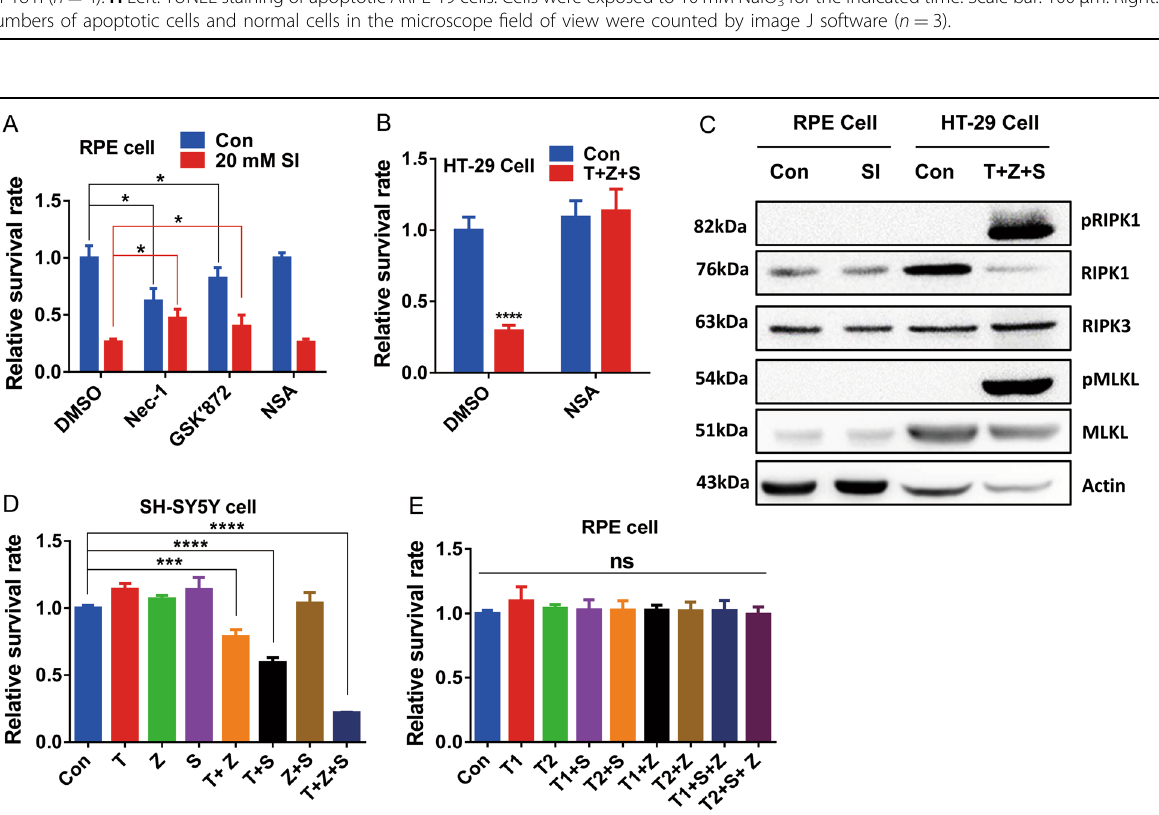
SI-induced death of APRE-19 cells or primary mouse RPE cells (Fig. 3E, Fig. S2). The decreased cell viability under DFO treatment without SI treatment as shown in Fig. 3E is likely due to the cytotoxicity of DFO 37 . In addition, using another iron chelator pyridoxal isonicotinoyl hydrazone (PIH), which is more membrane permeable